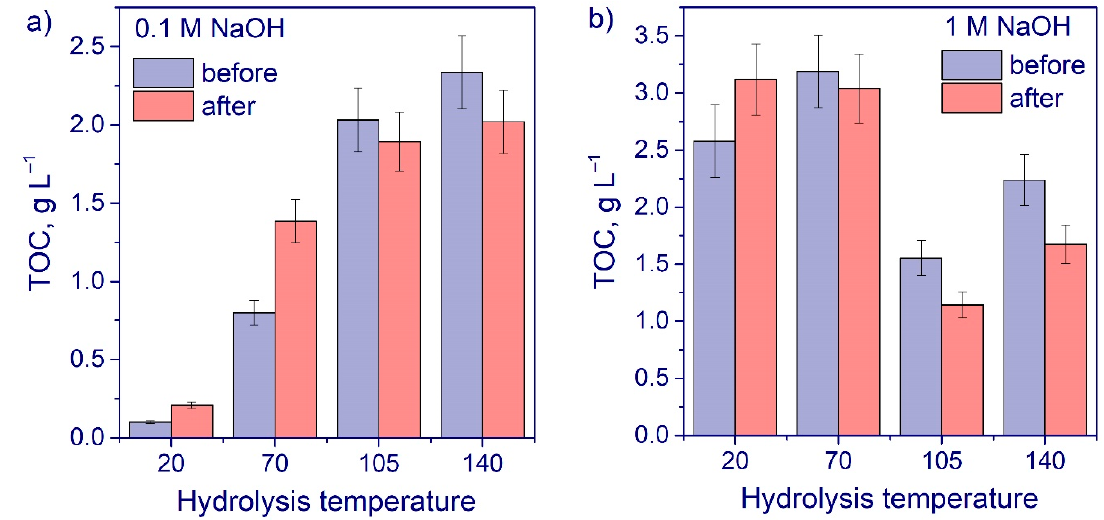
Figure 7. TOC content in reaction mixture before and after photocatalytic reaction at different hydrolysis temperatures for 0.1 M NaOH ( a ) and 1 M NaOH ( b ) solutions.